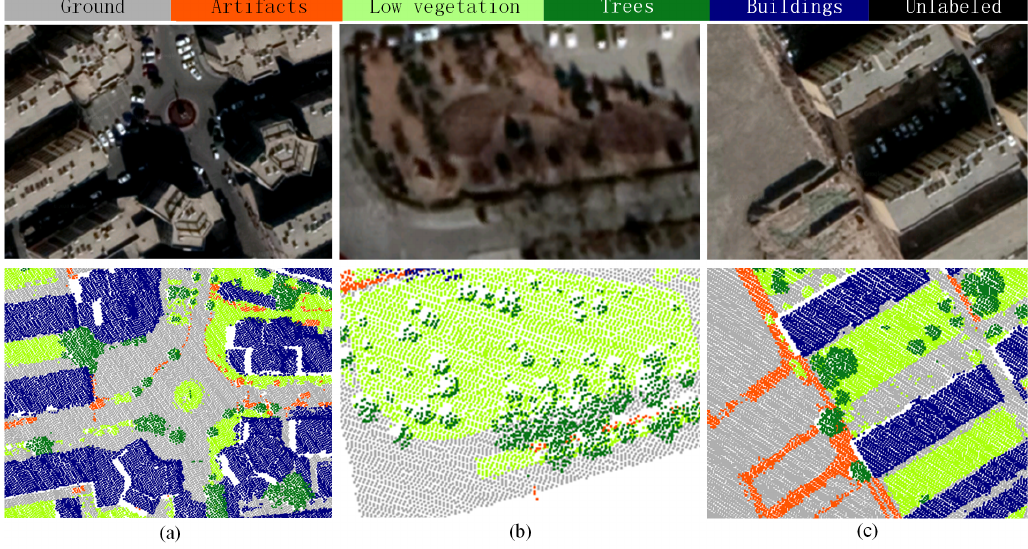
Figure 6. Examples of annotated points of different objects. ( a ) Buildings, flower beds, vehicles, and roads. ( b ) Grass, bushes, trees, and roads. ( c ) Buildings, bare land, short